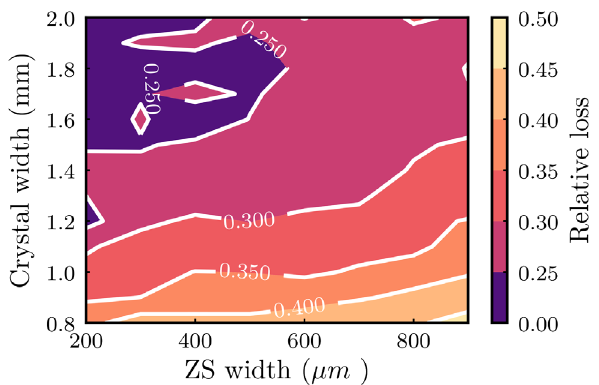
FIG. 13. Relative beam loss for nonlocal scenario parametrized as a function of the crystal and ES